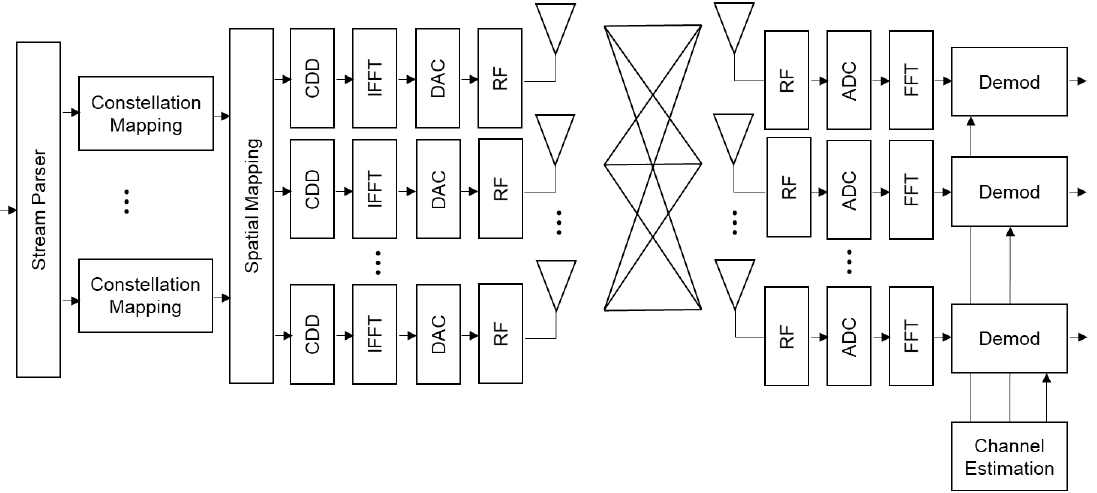
Figure 2. IEEE 802.11n transceiver configuration.